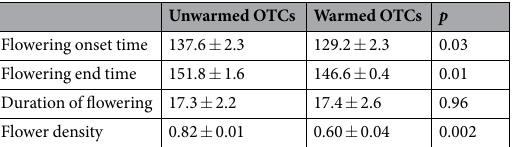
Table 1. Means ( ± SE) of flowering onset, end, duration (Julian day), and flower density (number of flowers per